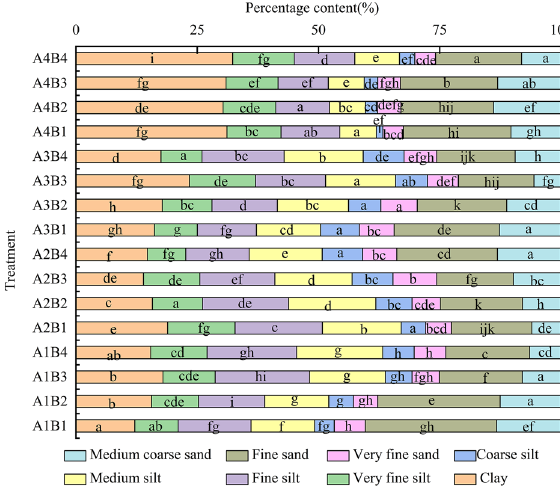
Figure 2. The particle size distribution of weathered